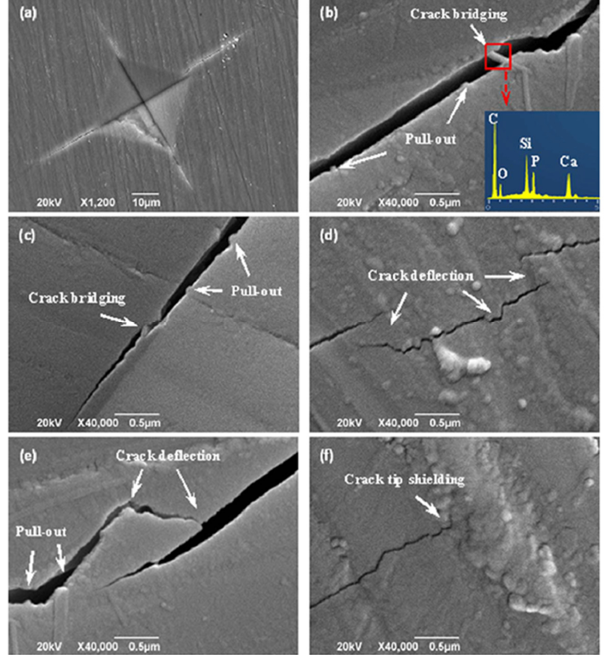
Figure 18. Crack propagation by graphene in the sintered samples. SEM images of ( a ) microhardness in dentation, ( b – e ) crack deflection, crack bridging and graphene pull-out, ( f ) closure of crack growth at the crack tip. Reproduced from [212] (CC BY).